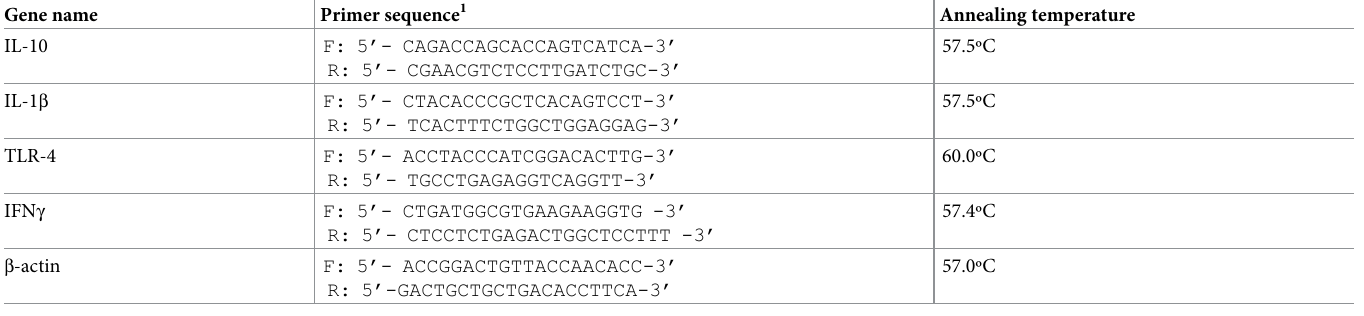
Table 1. Primer sequences and PCR conditions for housekeeping genes under study 1